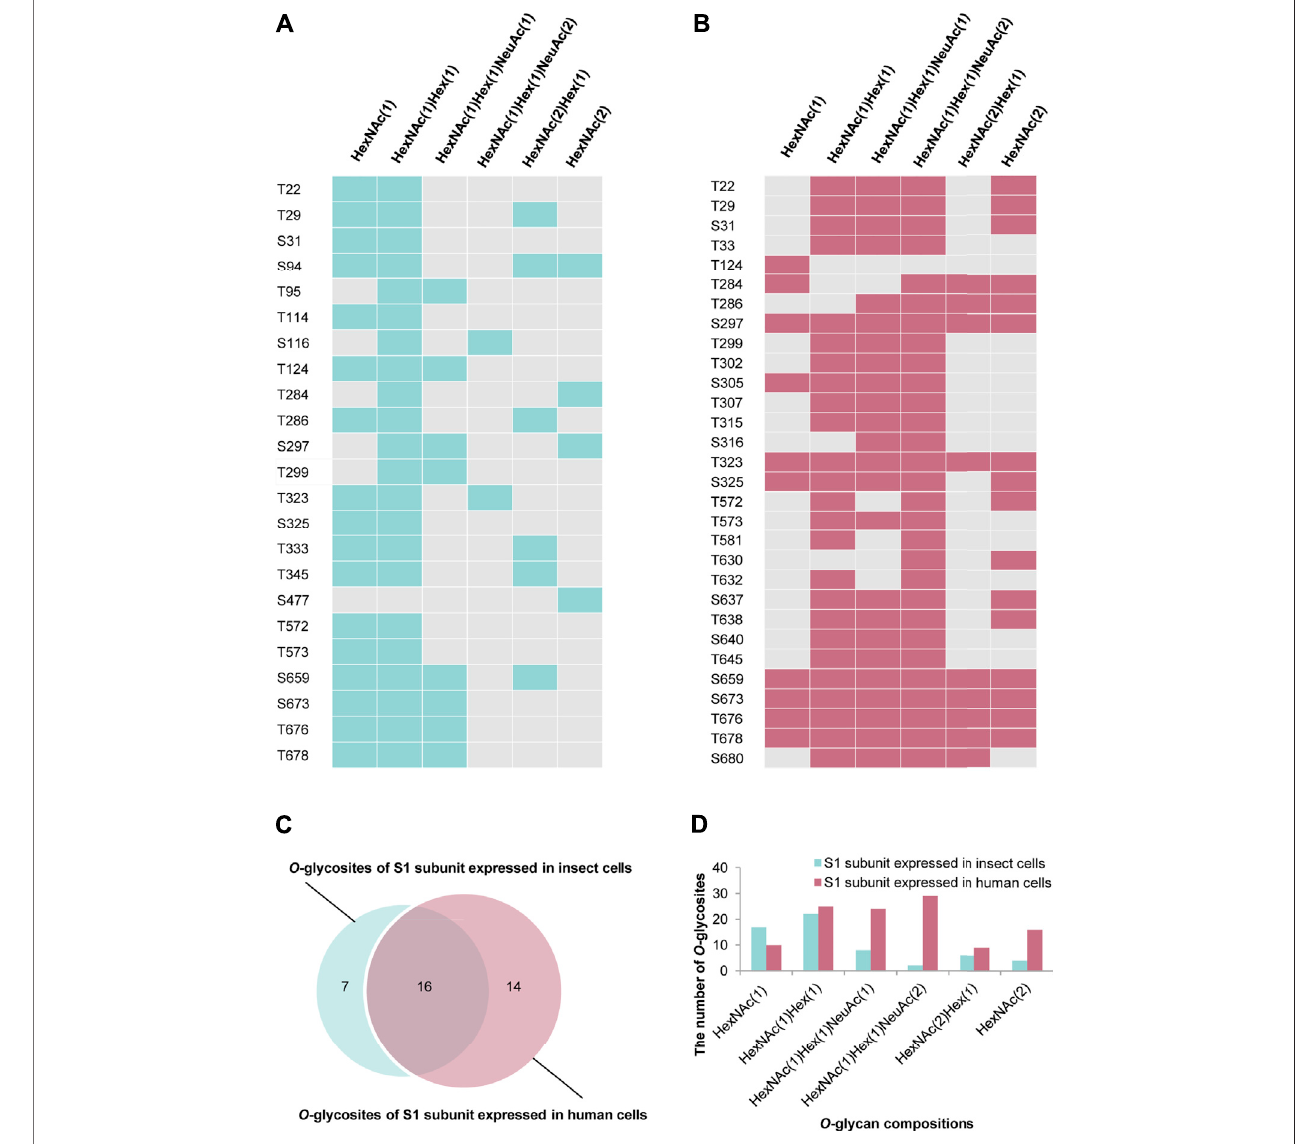
FIGURE 4 | Comparison of O -glycosylation modi fi cations of S1 subunits expressed in insect or human cells. (A) O -glycan compositions in each glycosite of S1 subunit expressed in insect cells. (B) O -glycan compositions in each glycosite of S1 subunit expressed in human cells. (C) Comparison of O -glycosites of S1 subunits expressed in different expression systems. (D) Number of S1 subunit O -glycosites attached by each type of O -glycan composition.